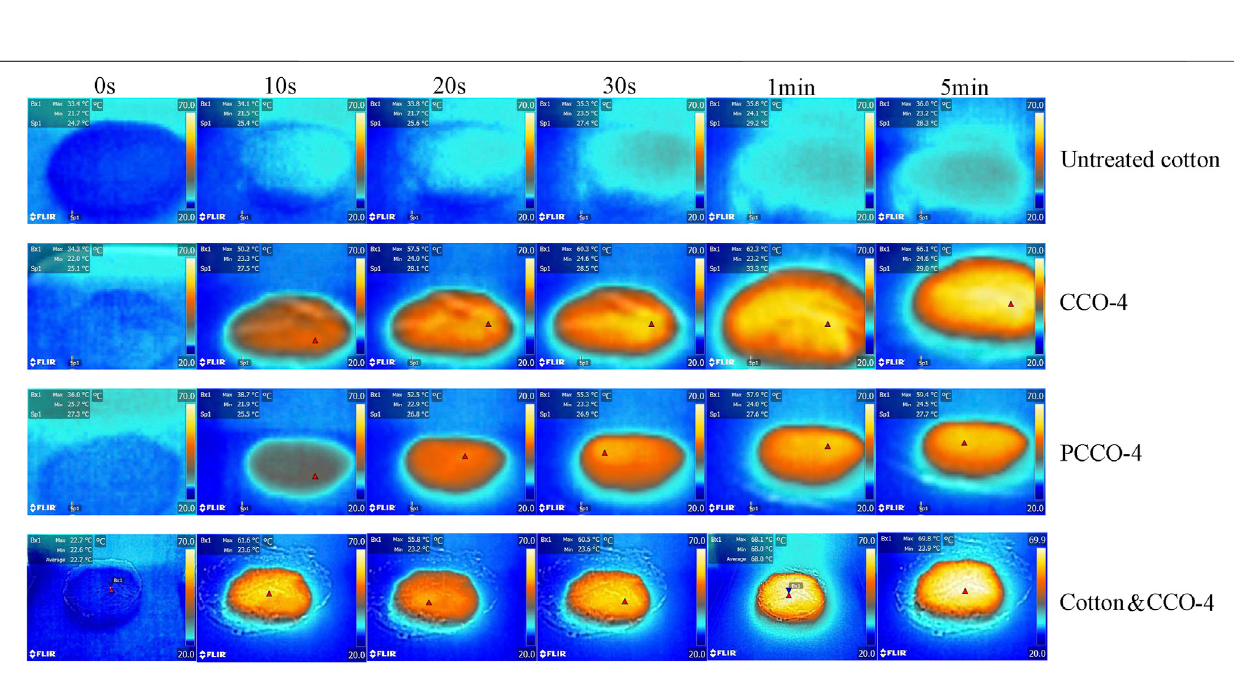
Frontiers in Energy Research |